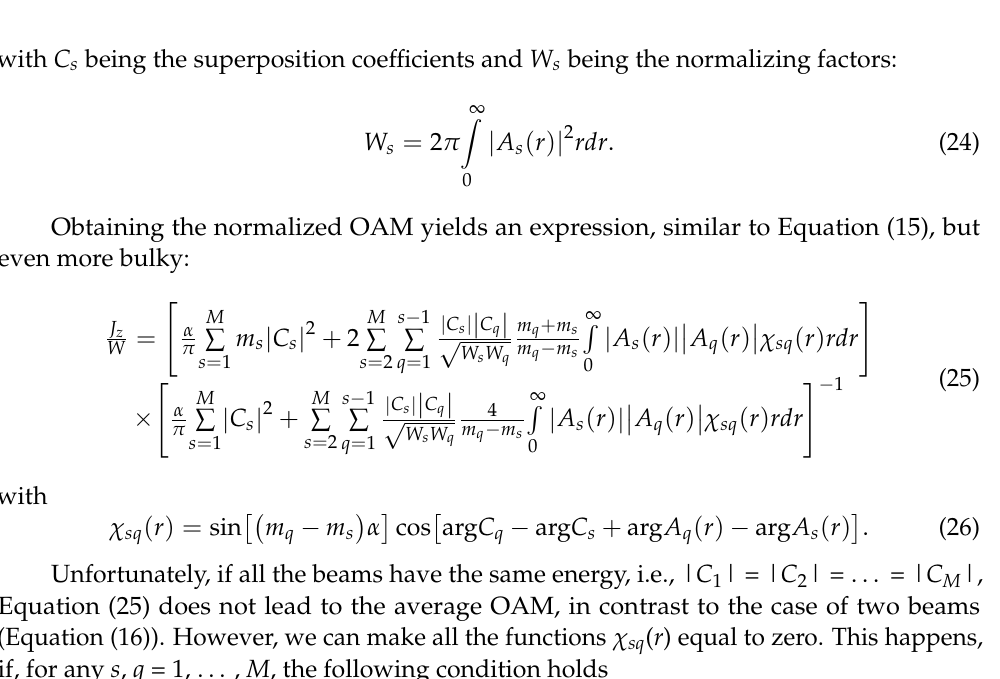
normalized OAM: 7.999 (Figure 5a,b), and 7.991 (Figure 5c,d). The greatest common divisor of all possible differences between the topological charges 6, 9, and 12, is 3, and, indeed, the OAM is conserved for the aperture with the half-angle π